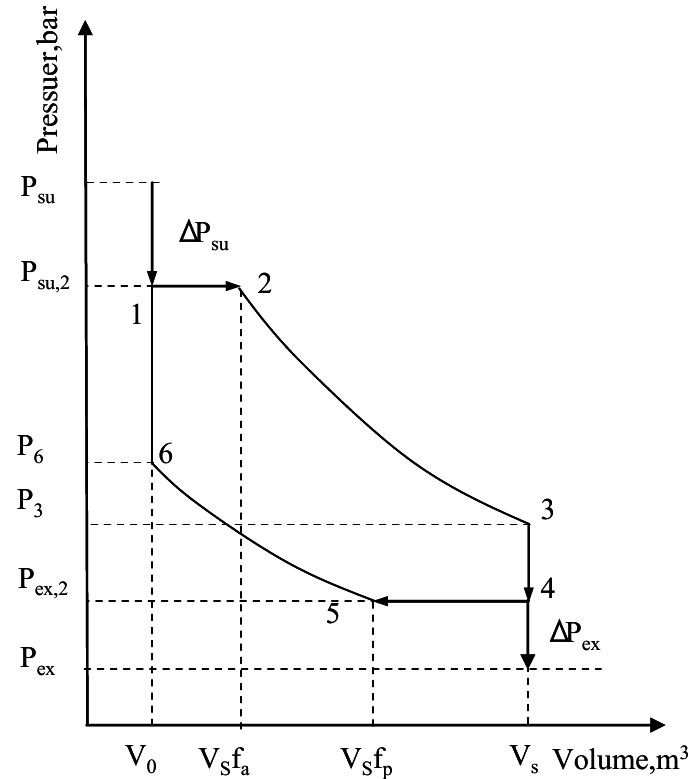
Figure 2. PV diagram representing the internal expansion